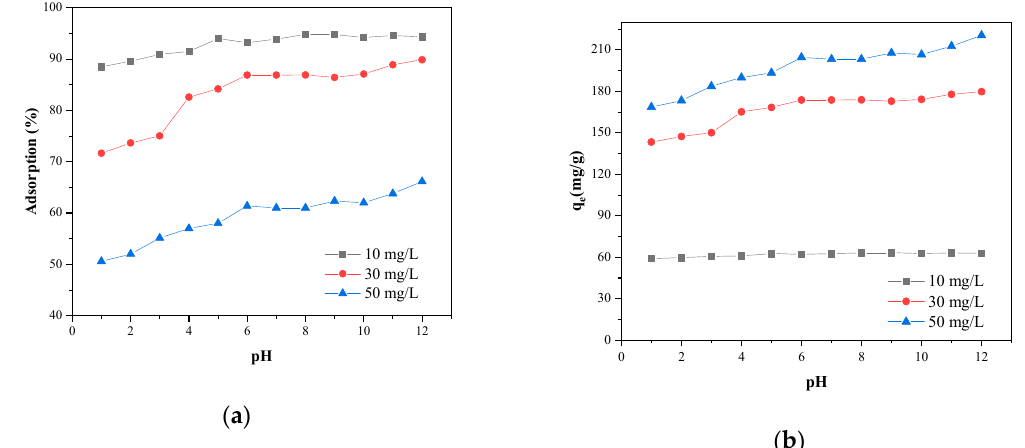
Figure 5. The adsorption rate ( a ) and the adsorption capacity (q e ) ( b ) of MB adsorption on the SLS-C sample at various pH values (S/L = 0.15 g·L − 1 , contact time = 120 min, 25 °C).